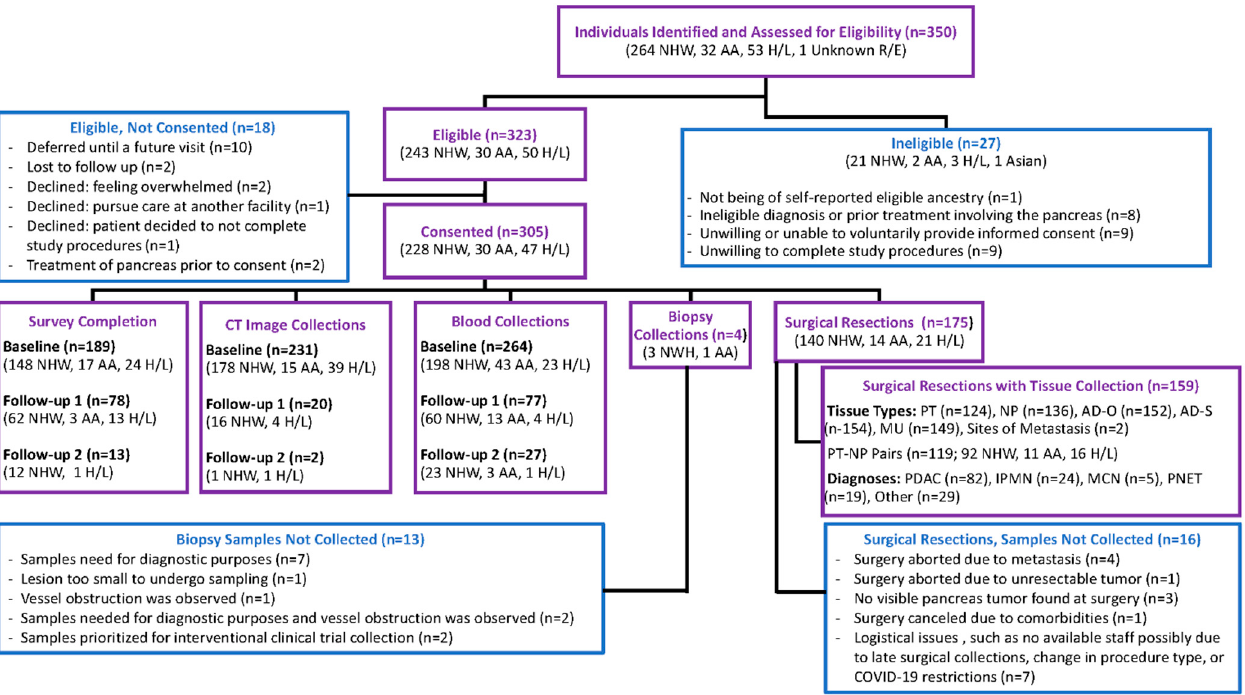
Figure 3. Summary of Recruitment, Survey Data, Image, and Biospecimen Collection Efforts to Date, by Race/Ethnicity. The flow diagram depicts the number of individuals eligible and ineligible for the study, as well as number of consented participants who have donated biospecimens, computed tomography (CT) images, and completed surveys. Abbreviations: Non-Hispanic White (NHW), African American (AA), Hispanic/Latinx (H/L), Pancreatic Tumor (PT), Normal Pancreas (NP), Adipose–omental (AD-O), Adipose–subcutaneous (AD-S), Muscle (MU), Pancreatic Ductal Adenocarcinoma (PDAC), Intraductal Papillary Mucinous Neoplasm (IPMN), Mucinous Cystic Neoplasm (MCN), Pancreatic Neuroendocrine Tumor (PNET). Table 4. Baseline demographic and clinical characteristics of Florida Pancreas Collaborative study participants, by race/ethnicity.